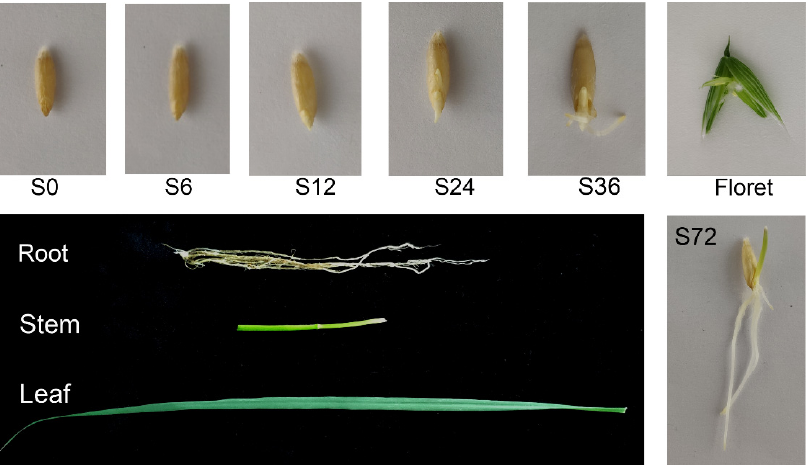
Figure 1. Tissue samples used for oat PacBio sequencing. Embryos samples were collected from oat seeds imbibed for 0 h (S0), 6 h (S6), 12 h (S12), 24 h (S24), and 36 h (S36). Oat seeds imbibed for 6 h (S6) and 24 h (S24) were used to collect endosperms. Seedlings were obtained from oat seeds